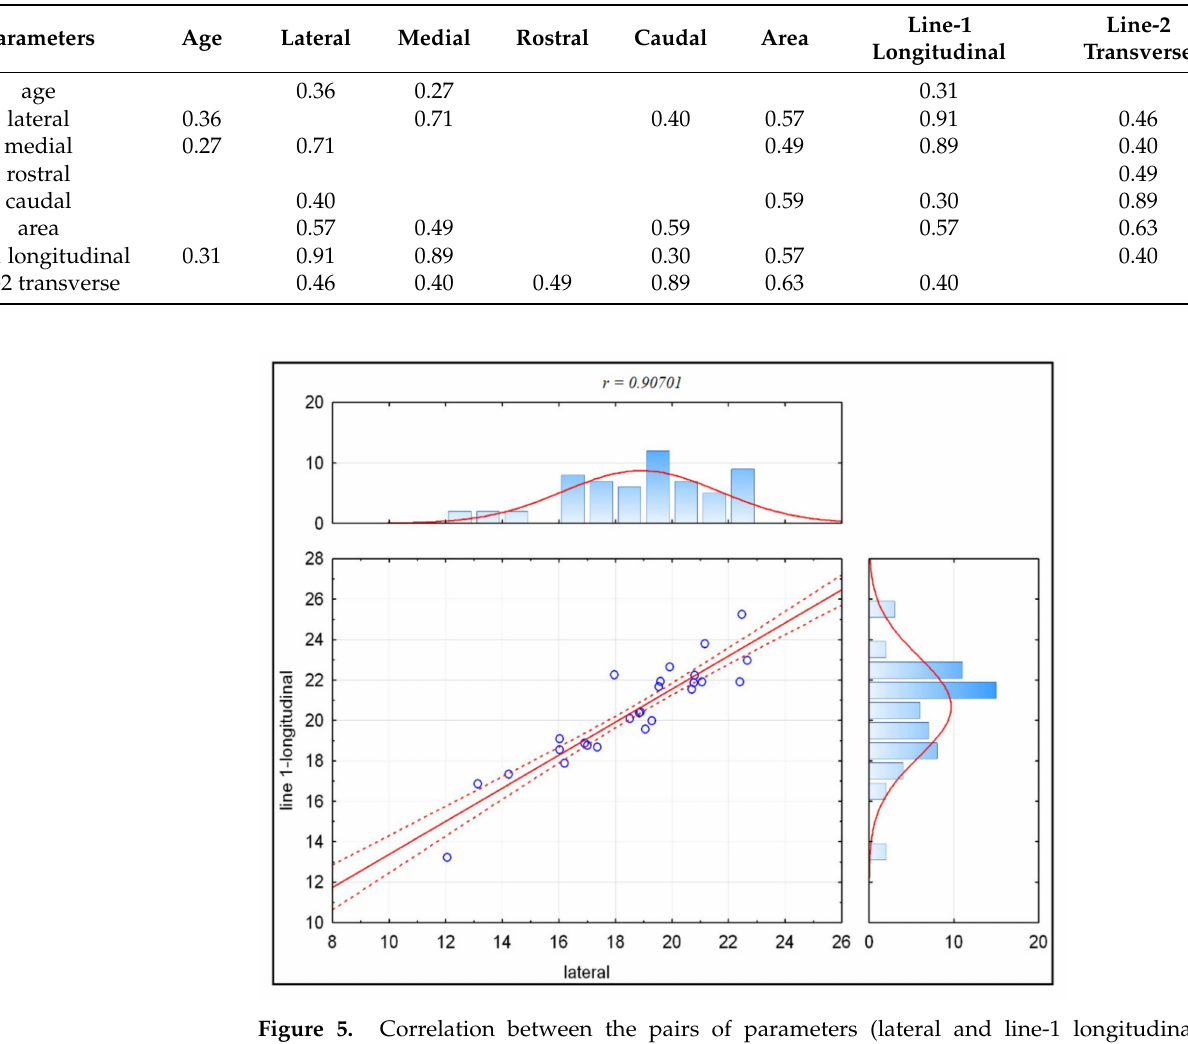
Figure 5. Correlation between the pairs of parameters (lateral and line-1 longitudinal) in female